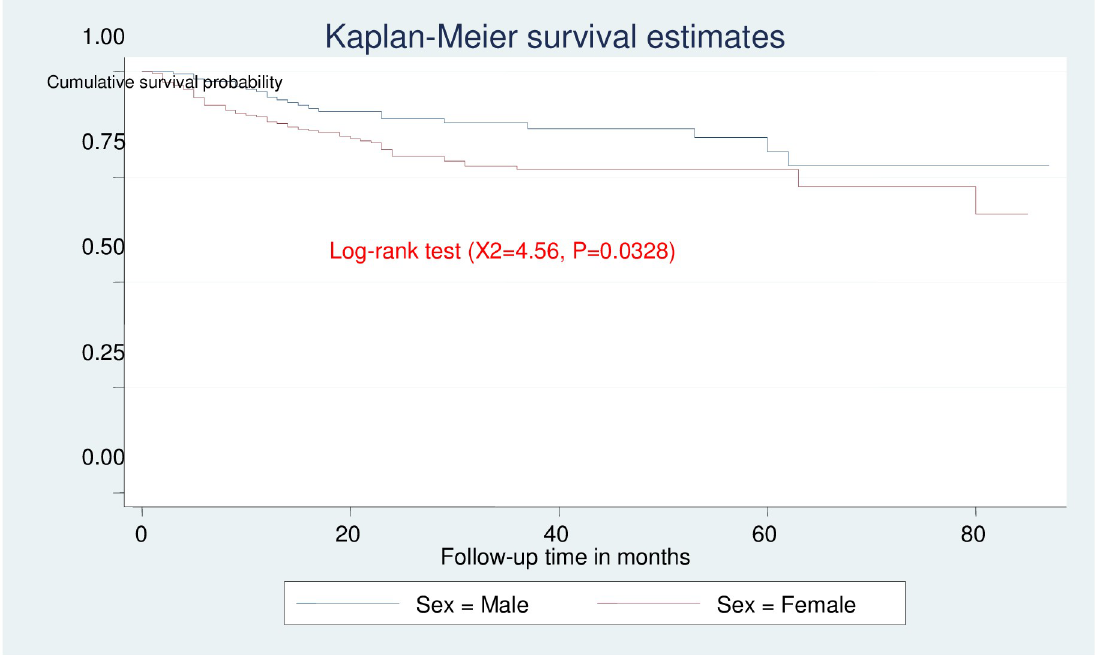
Fig 4. Kaplan-Meier survival estimate for sex among adult HIV patients on ART in public health facilities of Arba Minch town, southern Ethiopia, 2020.